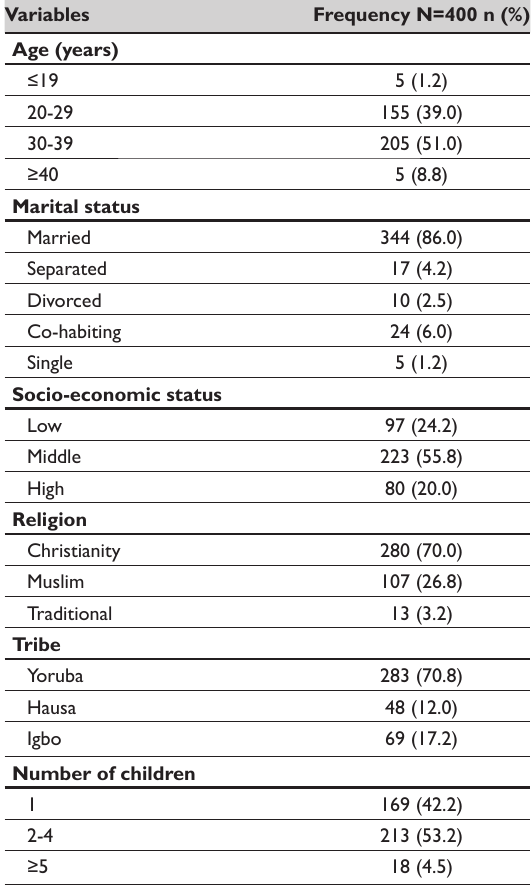
Table 1. Sociodemographic Characteristics of the Study